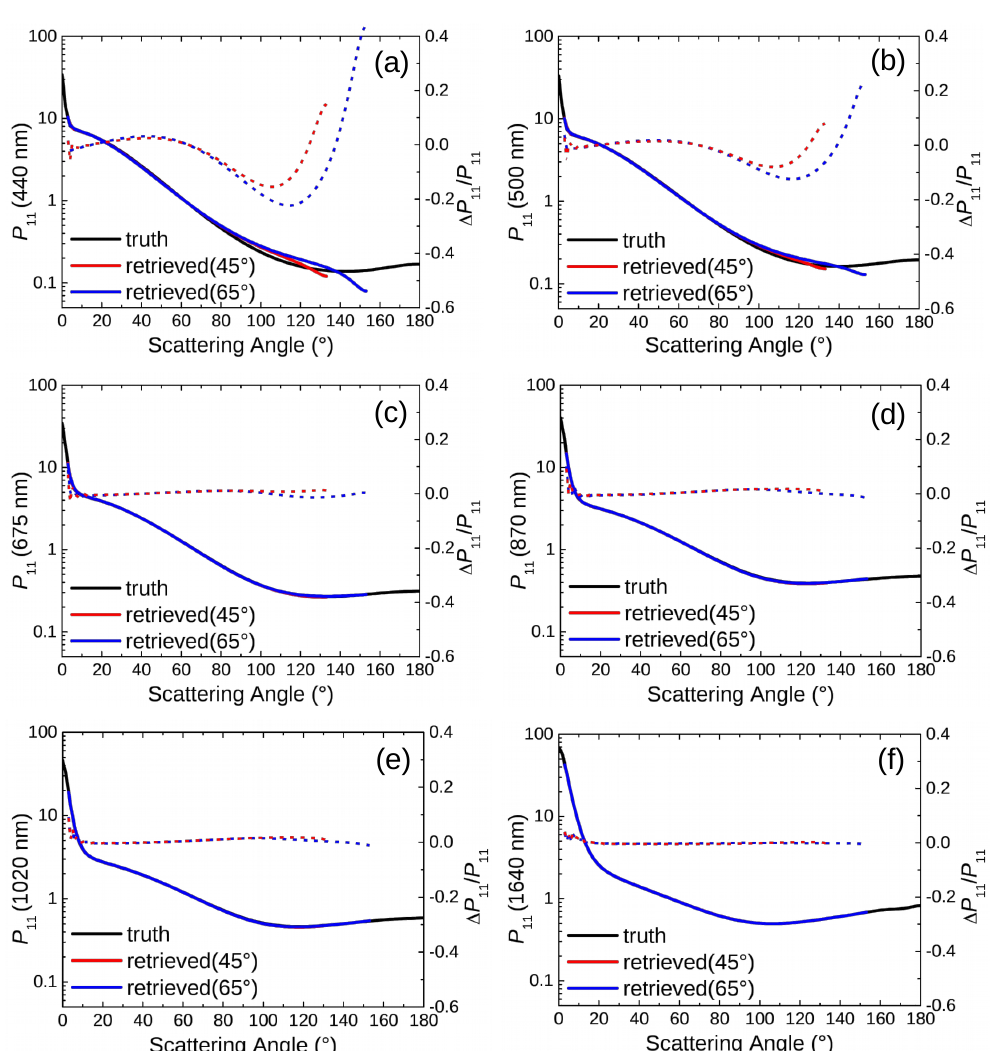
Figure 1. Comparison of P 11 retrieved from the Stokes parameter I at different solar zenith angles for the principal plane observation geometry. The curve notation is as: red solid lines for results of P 11 with solar zenith angle (SZA) of 45 0 ; red dashed lines for relative errors with SZA of 45 0 ; blue solid lines for results of P 11 with SZA of 65 0 ; blue dashed lines for relative errors with SZA of 65 0